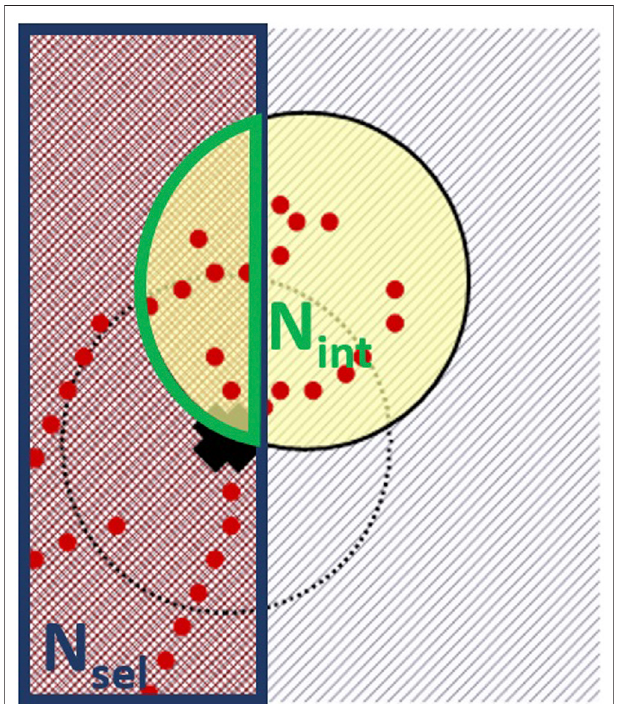
FIGURE 3 | Detail of the working principle of the weighted sampling method in Figure 2B . The compensation factor is computed as the ratio between the number of selectable hits (with deposited energy different from zero) in the hit selection region ( N sel ) and the number of hits in the intersection volume of the site with the hit selection region ( N int ).